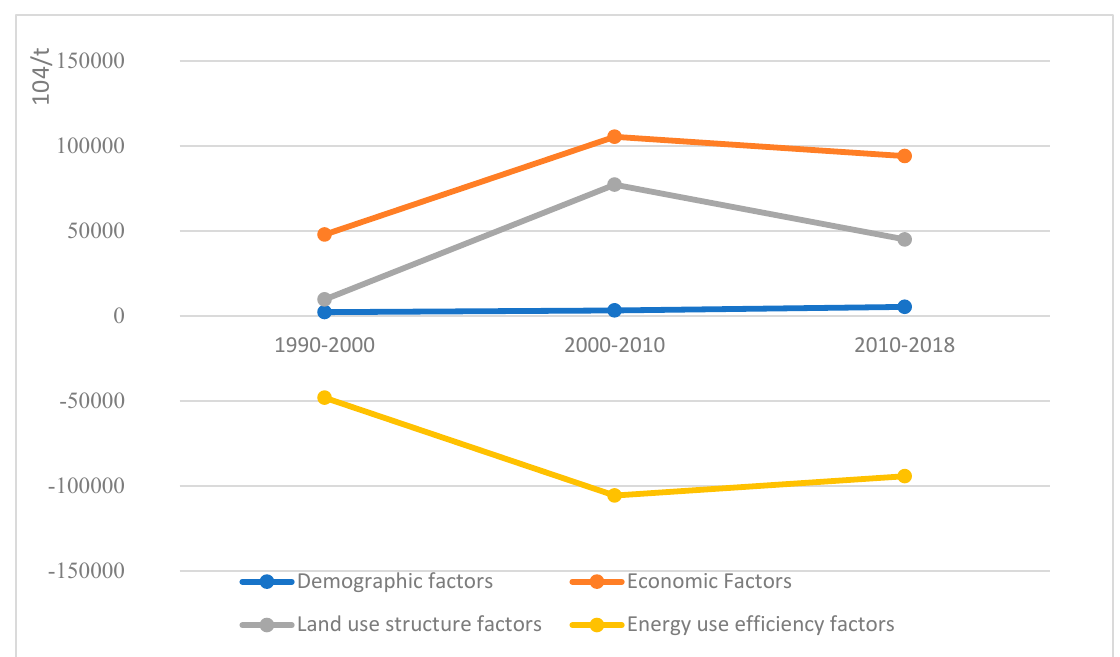
Figure 4. Decomposition result of land-use carbon emission factors in the study area (10 4 t).